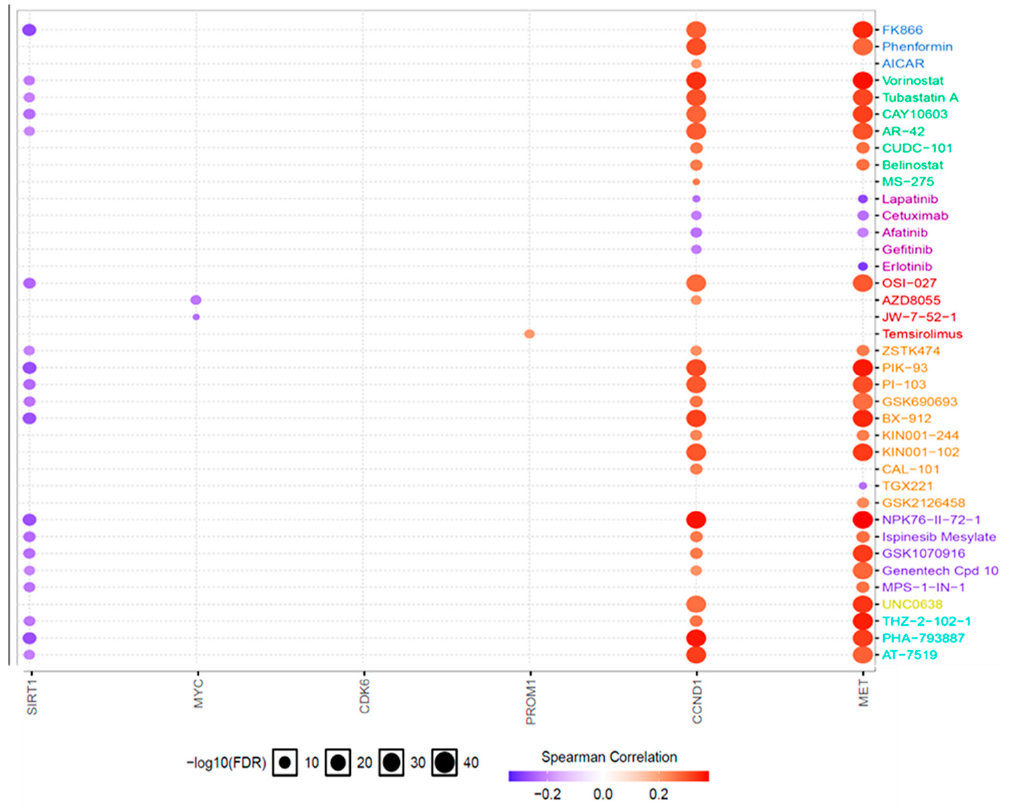
Figure 9. Drug sensitivity of the c-Met/GSK3 β /MYC/CCND1 oncogenes from the GSCA. Corre- lations among genomics of drug sensitivity in cancer (GDSC) of FDA-approved drugs. Positive Spearman correlation coefficients (orange circles) indicate that increased gene expression levels were resistant to the drug, compared to negative correlations shown in blue, which indicate sensitivity to the